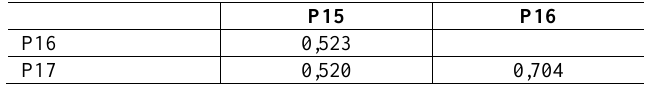
Table 4: Correlation coefficients for Processes (P)